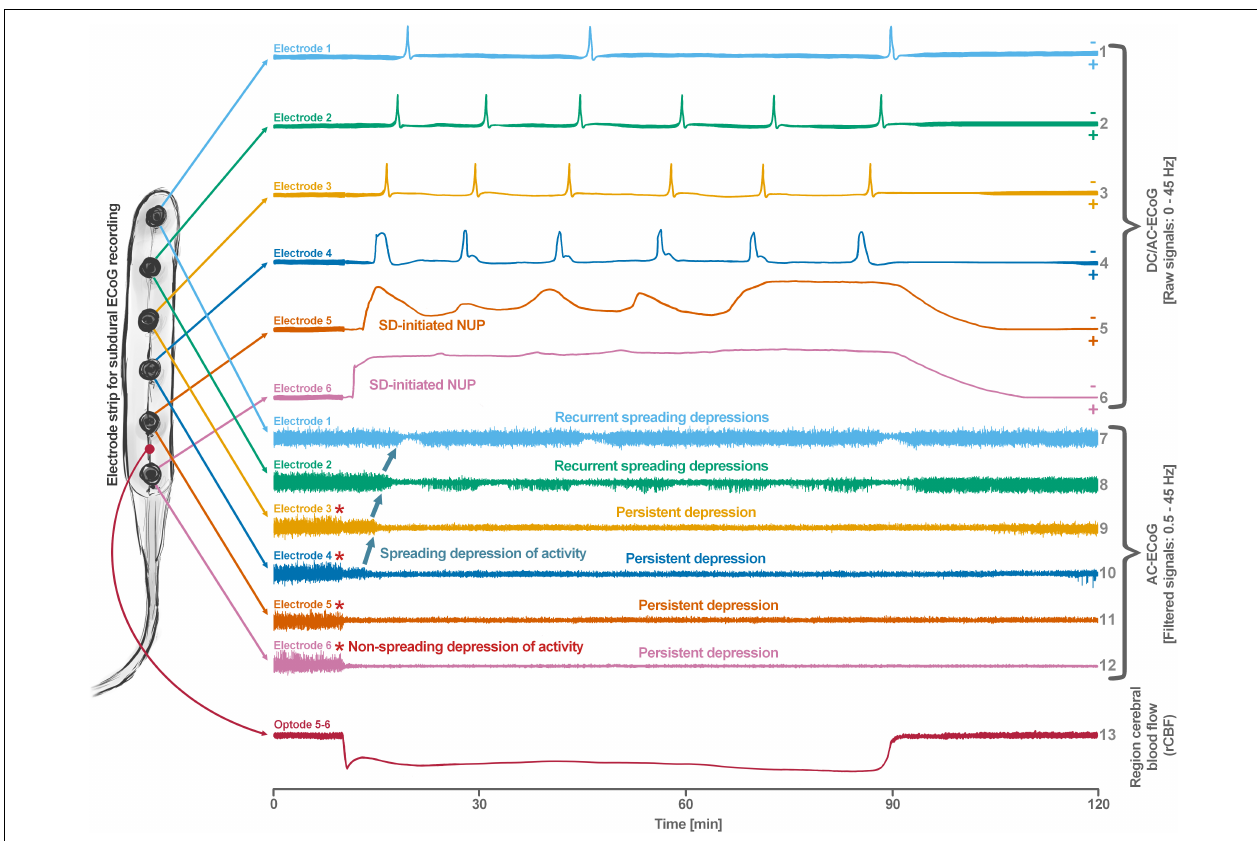
FIGURE 1 | Schematic representation of the spreading depolarization (SD) continuum associated with different spontaneous brain activity changes after middle cerebral artery occlusion (MCAO). Traces 1–6 from top to bottom give the direct current (DC)/alternating current (AC)-electrocorticography (ECoG) recordings (band-pass: 0–45 Hz) where spreading depolarizations are recorded as large negative DC shifts. The ECoG traces are oriented with negativity upward and positivity downward according to the electroencephalography (EEG) convention. The following 6 traces (7–12) show the high frequency band (AC-ECoG, band-pass: 0.5–45 Hz) were changes in the spontaneous brain activity can be assessed. The last trace (13) represents the regional cerebral blood flow (rCBF) recorded with an optode for laser-Doppler flowmetry located between electrodes 5 and 6. From these recordings, we can retrieve both temporal information ( x -axis: time) and spatial information [ y -axis: the electrode strip is composed of 6 electrodes overlying brain cortex from the ischemic center (electrode 6) to the adequately perfused periphery (electrode 1)]. Along the x -axis, the first prominent event is the drop in rCBF as a result of MCAO (trace 13). A few seconds after this focal drop in rCBF, the first signs of non-spreading activity depression begin at electrodes 6–3, with the non-spreading depression being most pronounced in the ischemic center below electrode 6 (red asterisks at AC-ECoG traces 12–9). Approximately 1 min after the drop in rCBF, the first spreading depolarization begins in the ischemic center at electrode 6 and spreads concentrically from electrode 6 to electrode 1 (first negative DC shift in the DC/AC-ECoG traces 6–1). Importantly, the first spreading depolarization begins long before cell death develops, which is ultimately a consequence of toxic changes in the intraneuronal environment due to persistent spreading depolarization. Thus, the first spreading depolarization initiates a high-amplitude negative ultraslow potential (NUP) in the DC/AC-ECoG traces of electrodes 6 and 5 (traces 6 and 5), defining the later ischemic core region. In the AC-ECoG traces of electrodes 4–1, the first spreading depolarization induces spreading depression of activity (dark green arrows between traces 10–7). Note that spreading depolarization-induced spreading depression at electrode 3 (trace 9) similar to that at electrode 4 (trace 10) results in persistent activity depression, although electrode 3, unlike electrode 4, lies outside the actual ischemic penumbra (Oliveira-Ferreira et al., 2010). Spreading depolarizations in persistently depressed tissue are called isoelectric spreading depolarizations (traces 5–3 and 11–9) (Hartings et al., 2011a; Dreier et al., 2017). The first spreading depolarization at electrodes 6 and 5 cannot induce spreading depression of activity because the activity has already been suppressed by non-spreading depression of activity. Not all spreading depolarizations reach tissue remote from the ischemic center. In this example, electrode 1 only recorded three of the six spreading depolarizations. The occluded MCA is reopened after 90 min immediately followed by reperfusion (trace 13). Although necrosis develops in the ischemic core region if reperfusion occurs later than 15–20 min after the onset of ischemia (Luckl et al., 2018), the DC potential often still shows some recovery from negativity if reperfusion occurs after 90 min. Later in the course, there may even be a transient return to extremely low-amplitude spontaneous activity in the region of the ischemic